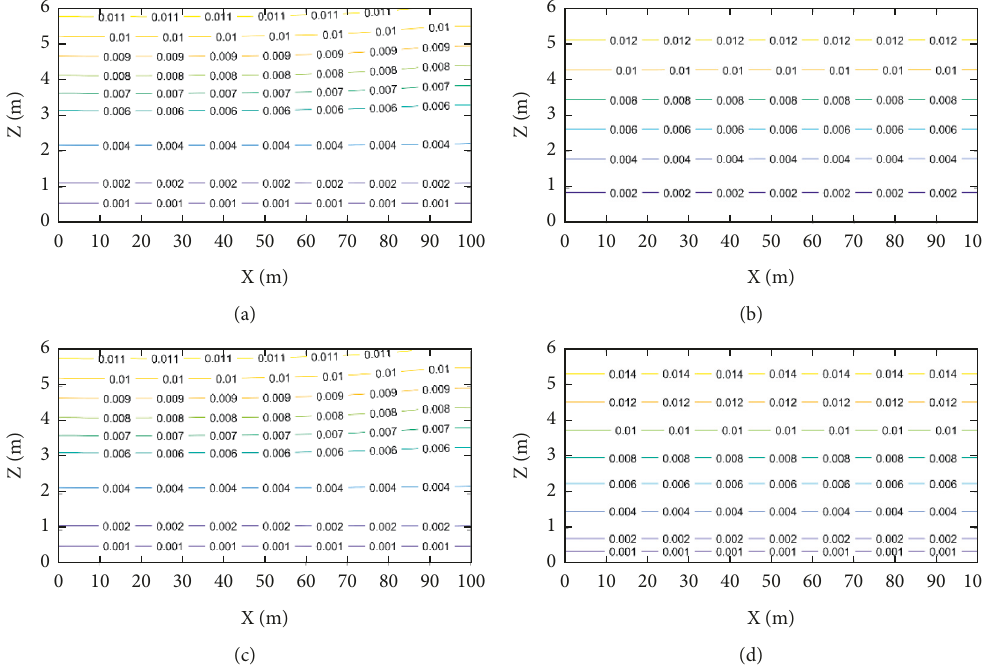
0 (unit: m 3 / t ). (a) 3days, (b) 10days, (c) 20days, and (d) 30days. (cid:31)